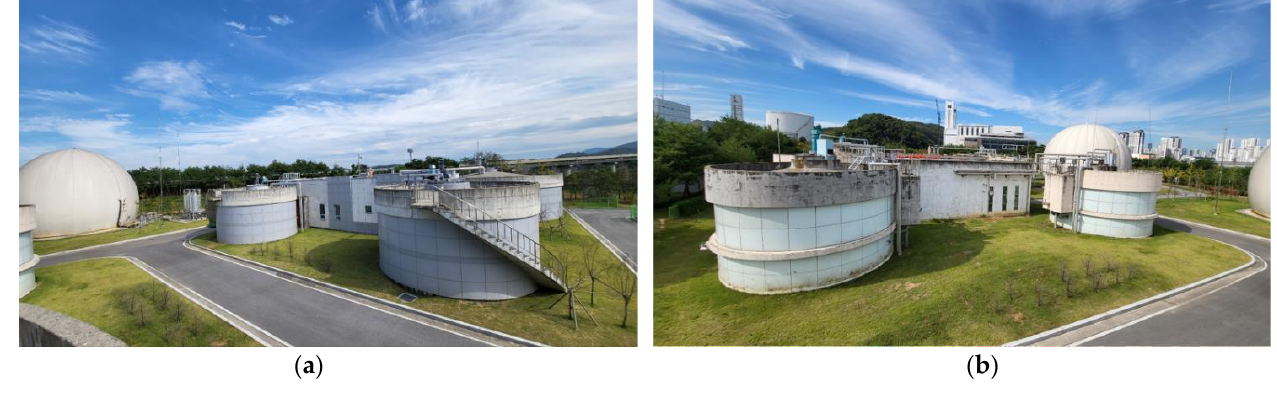
Figure 3. WWTP biogas facilities views: ( a ) is AD, ( b ) is AcoD. Table 1. Design capacity and operating usage.